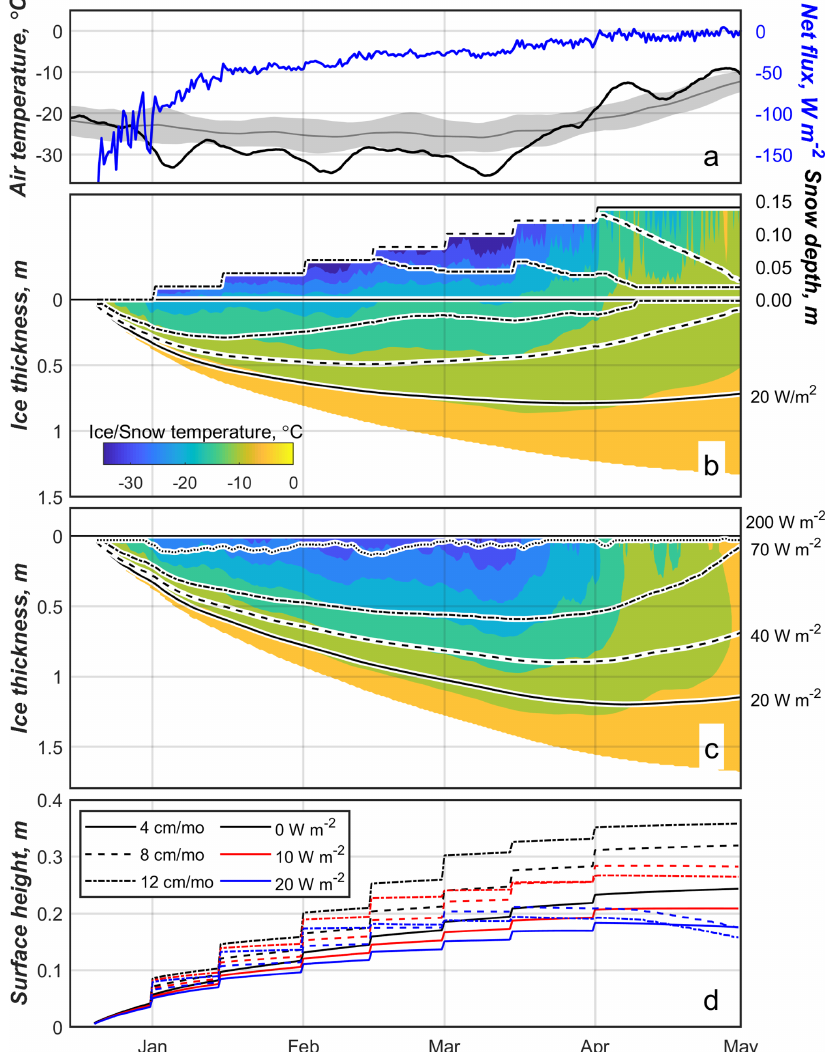
Figure 6. (a) The 2m air temperature (black) and the net surface heat flux (blue). Gray line and shading indicate the mean 1979–2020 temperature and standard deviation. (b) The modeled evolution of ice and snow temperature and thickness in the vicinity of polynya under a constant snowfall rate of 4cm per month (corresponding to 14cm of snowpack at the end of March). (c) The same as (b) but under no-snow conditions – a proxy of the polynya at Cape Jackson. Black lines in (b) and (c) show the evolution of ice and snow thicknesses if an additional heat flux of 20 (solid), 40 (dashed), 70Wm − 2 (dashed–dotted) or 200Wm − 2 (dotted) from below is applied. (d) The calculated difference between the sea surface in ice-free polynya and the combined surface heights of ice and snow within surrounding ice for different snow accumulation rates and ocean heat